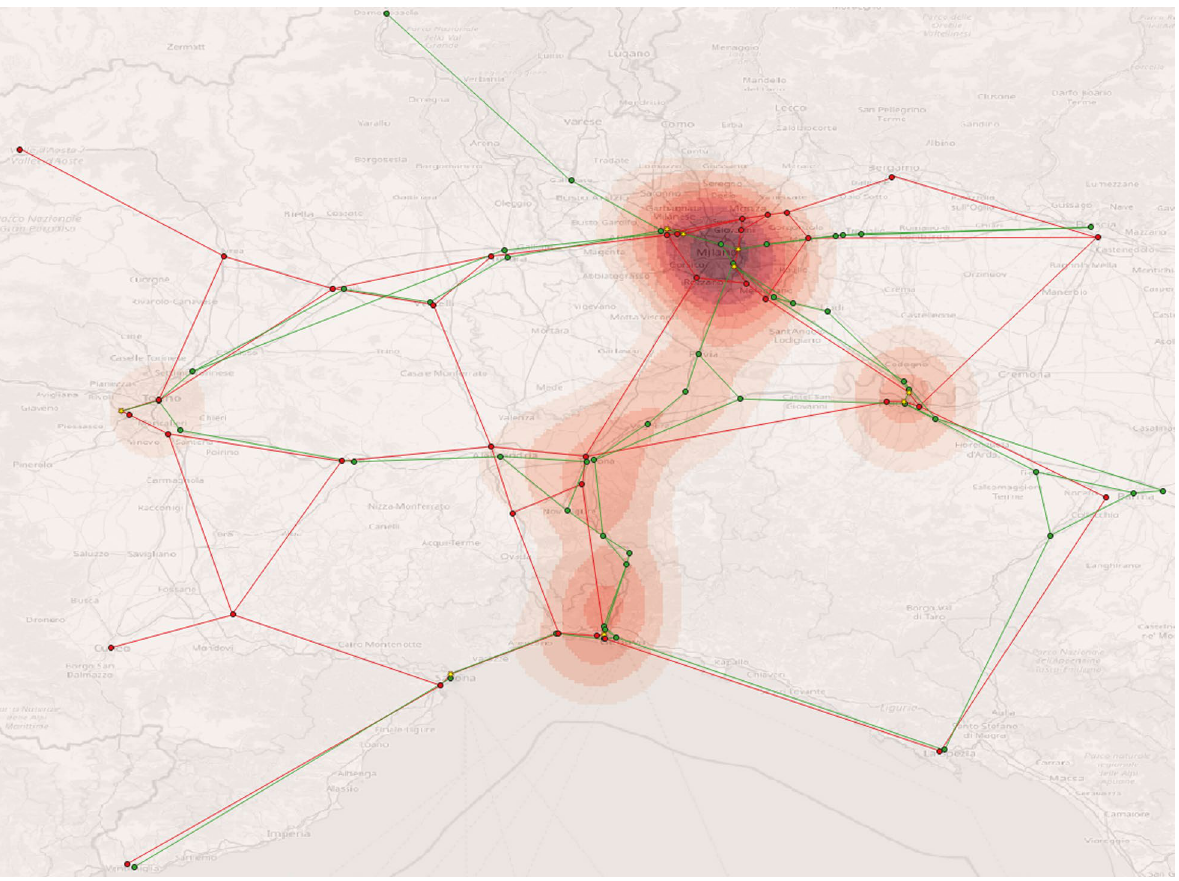
Fig. 9 Heatmap—Betweenness